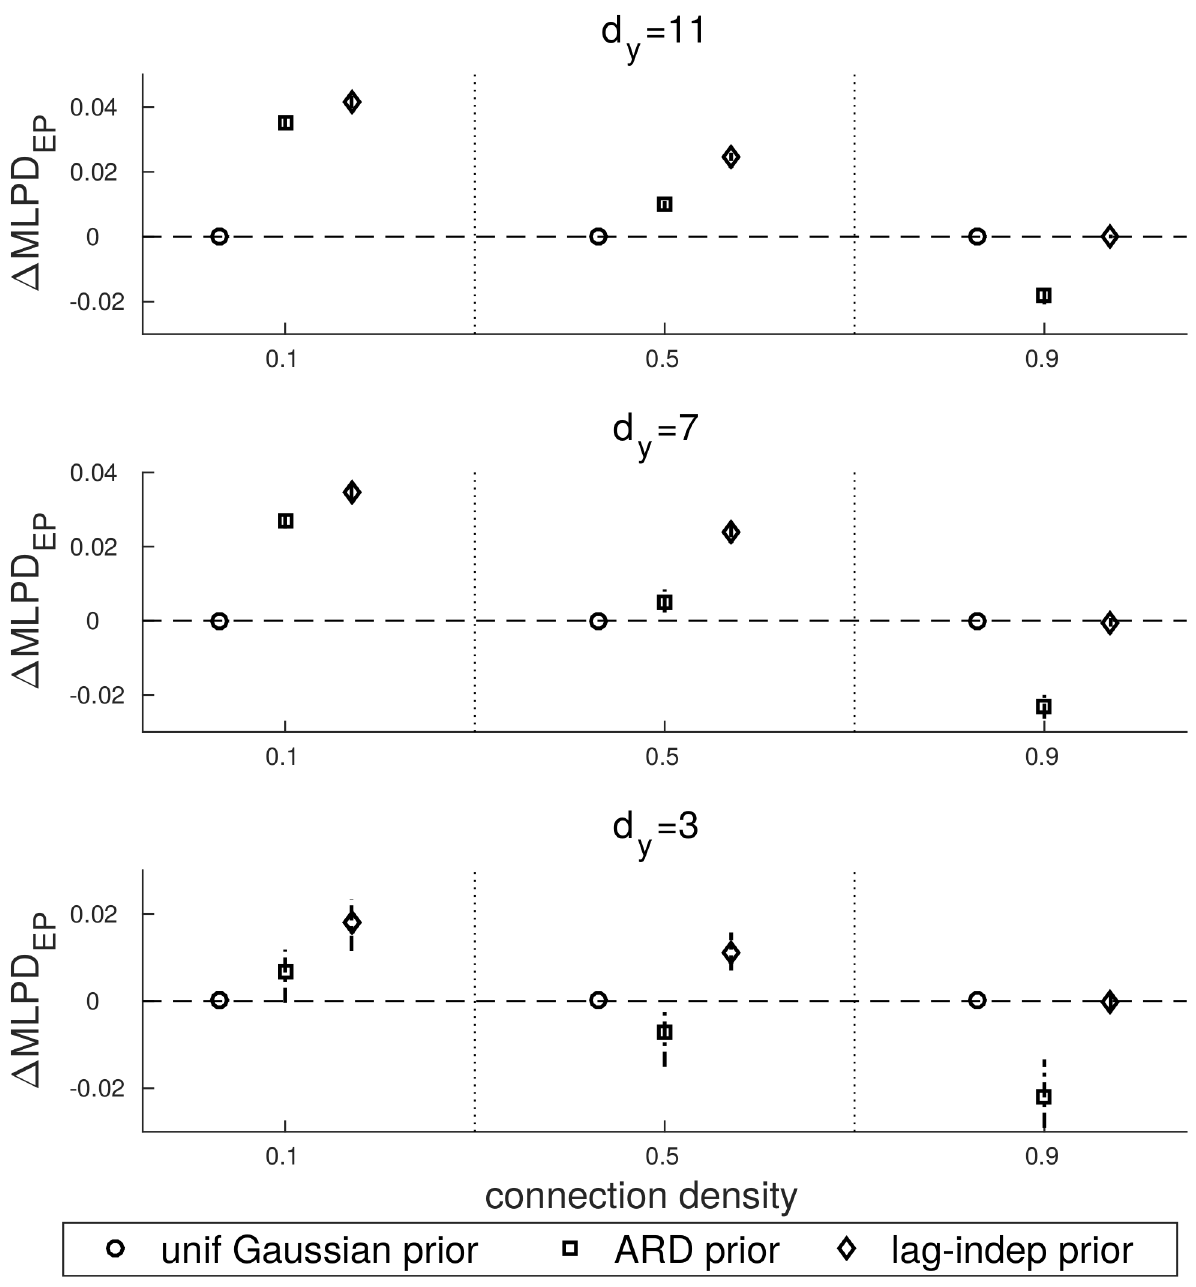
Fig 4. Δ MLPD computed with respectto the uniform Gaussian prior and evaluated on the EP iterations.